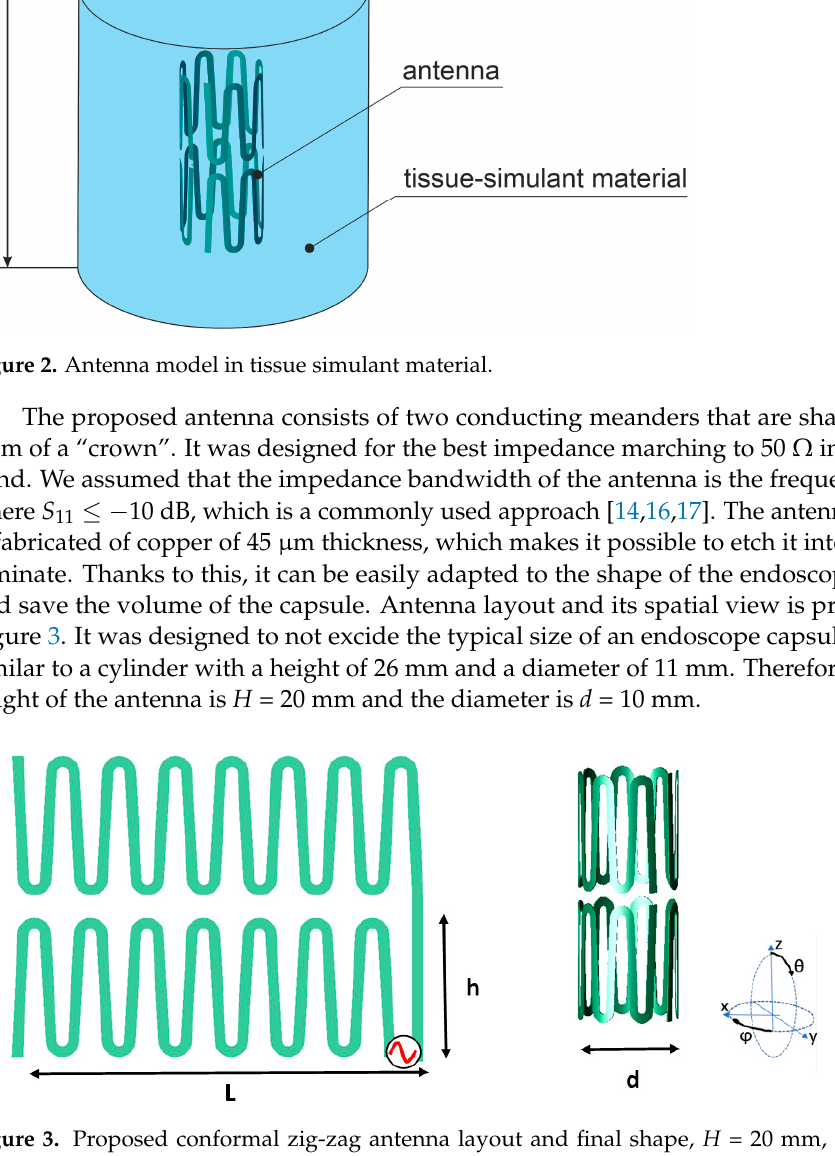
Figure 3. Proposed conformal zig-zag antenna layout and final shape, H = 20 mm, L = 33 mm, h = 9 mm, and d = 10 mm.